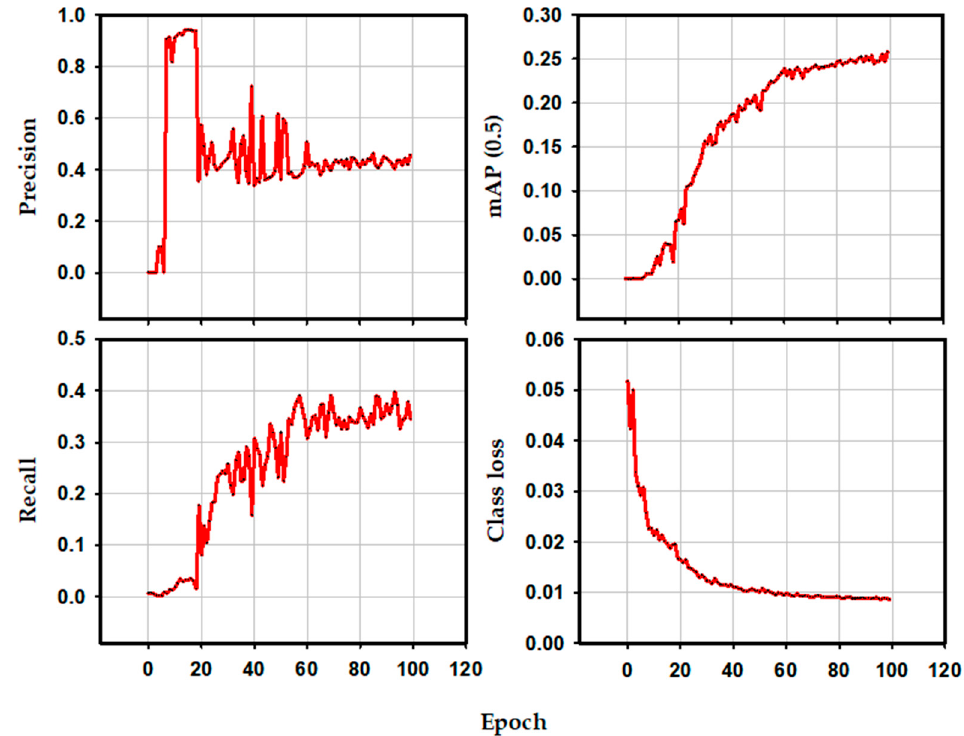
Figure 3. Plots of the precision, recall, mAP (0.5) parameters along with class object loss for training